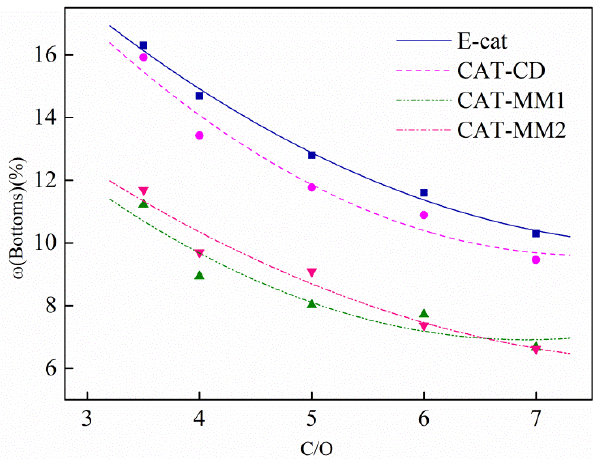
Figure 8. Bottoms as a function of the catalyst-to-oil ratio for different catalysts.